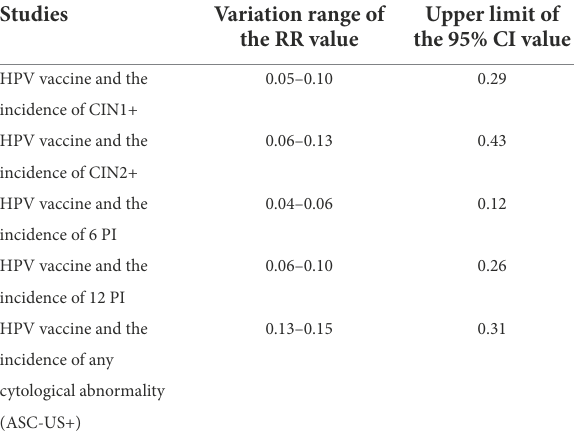
TABLE 2 Sensitivity analysis results of the efficacy of HPV vaccine on cervical cancer among the Asian